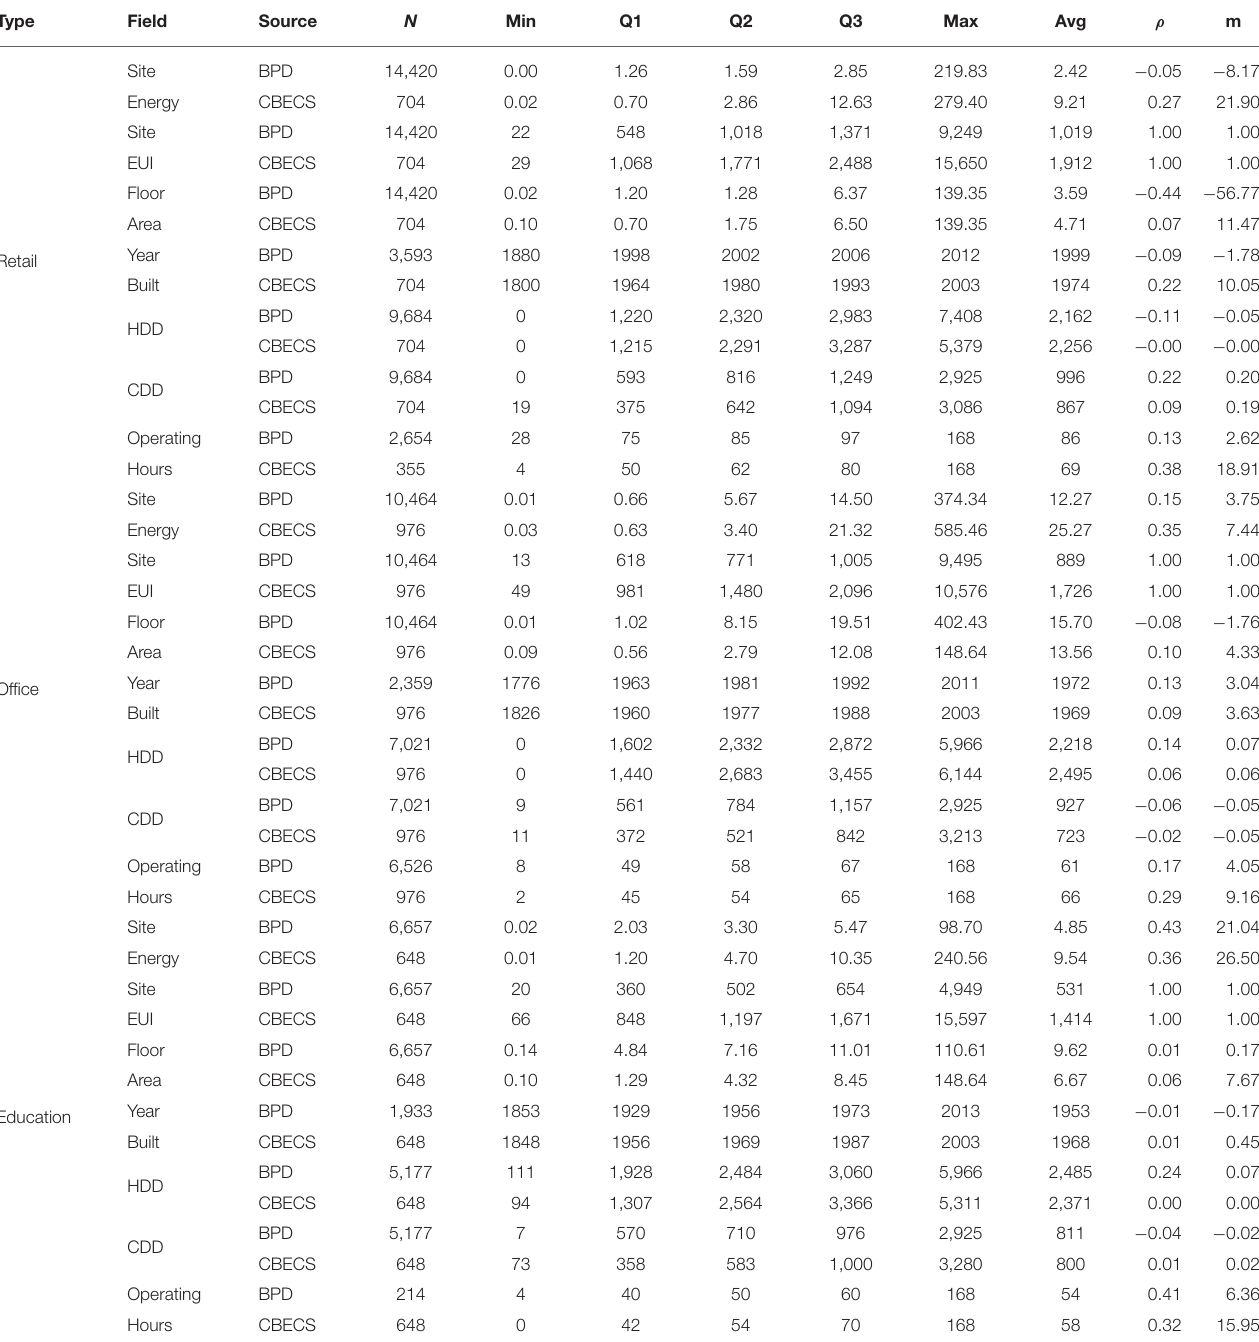
TABLE 2 | Table showing range and distribution of reported values in BPD and CBECS for office, education and retail buildings.